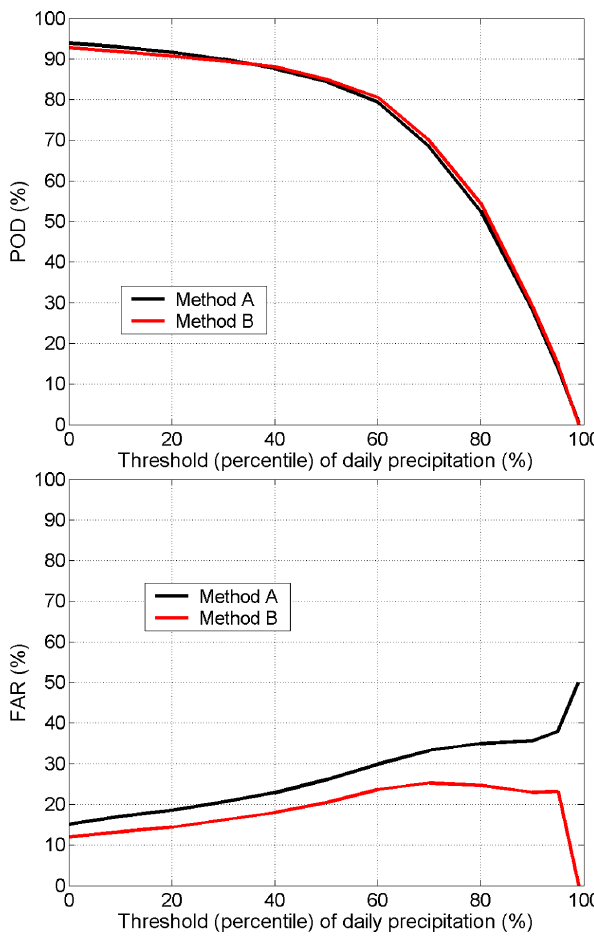
Fig. 2. POD and FAR scores obtained in perfect prognosis with methods A and B for different precipitation thresholds defined by percentiles of the climatological empirical distribution. The fore- cast value is represented by the 60% quantile of the